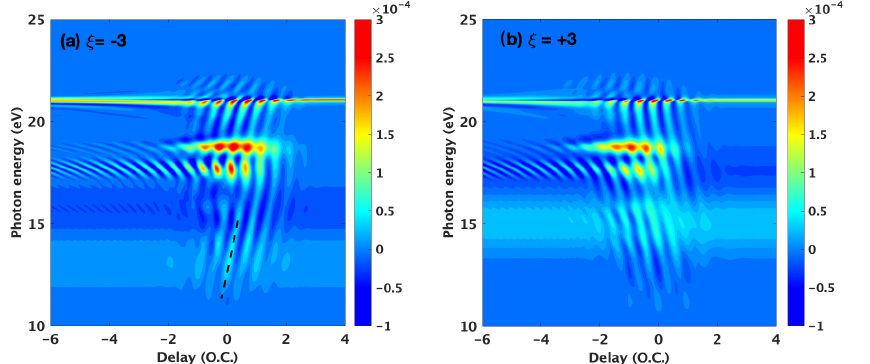
Figure 4. Absorption spectrum of helium atom obtained by calculating the response functions for two chirps: ( a ) ξ = − 3 and ( b ) ξ = +